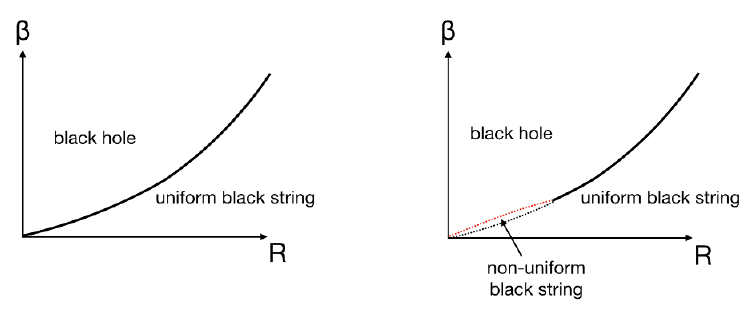
Figure 1. Possible phase diagrams of 2d maximal SYM on a circle in the canonical ensem- ble [9, 18]. The vertical axis is the inverse temperature, (cid:12) = T (cid:0) 1 and the horizontal axis is the radius R of the spatial circle. The phase transition is related to the breaking of center symmetry along the spatial circle, analogous to con(cid:12)nement and decon(cid:12)nement. Black hole, uniform black string and non-uniform black string phases on the gravity side correspond to the \completely" decon(cid:12)ned, con(cid:12)ned and \partially" decon(cid:12)ned phases, respectively. (See section 2.1 for the meaning of \complete" and \partial" decon(cid:12)nement.) Our numerical simulations tell us that the left (cid:12)gure is more likely to be